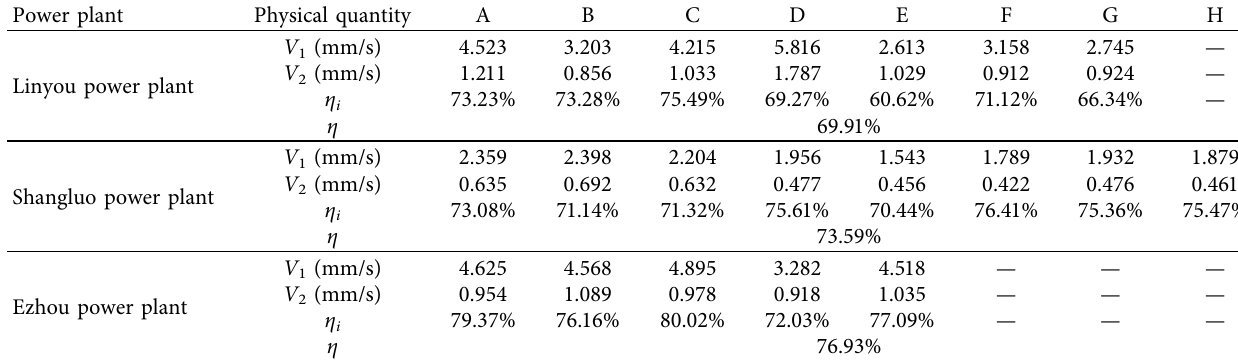
Table 5: Vibration-isolation efficiency.